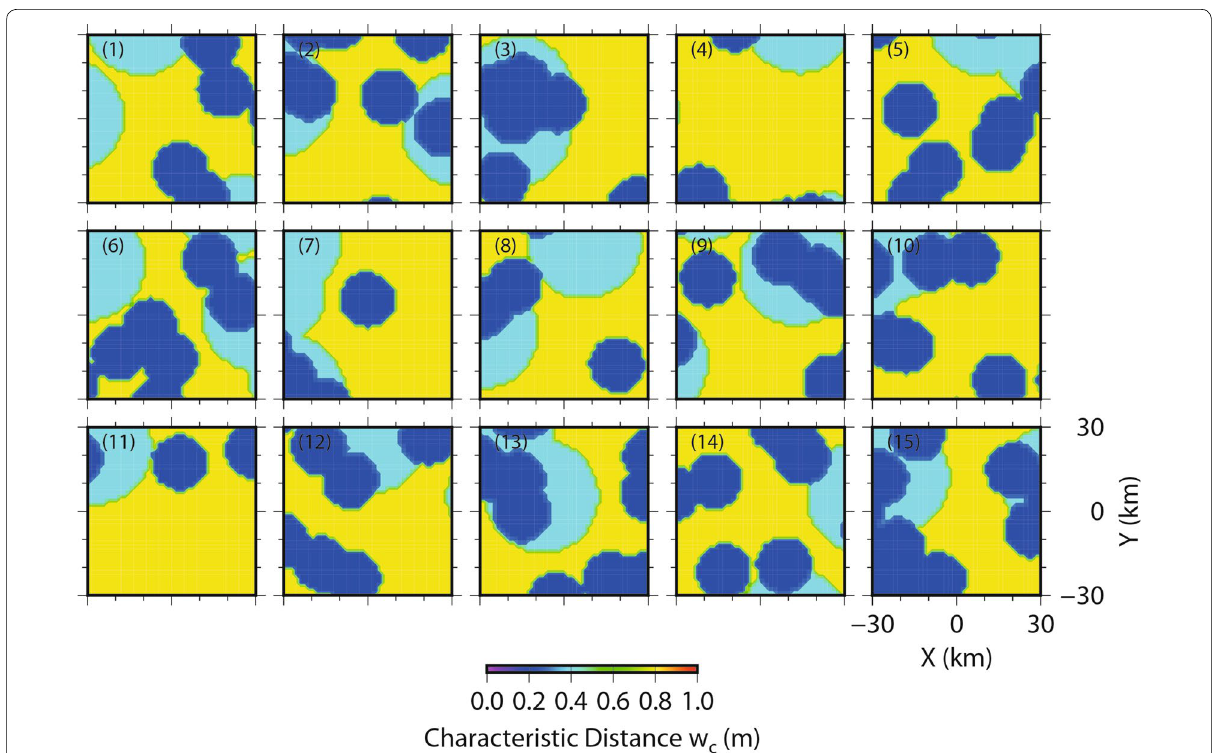
Fig. 12 Spatial distribution of multiscale patches for all 15 simulations, originating from those shown in Fig. 6. The lower limit of the structure is changed so that the smallest patches of rank k = 4 are